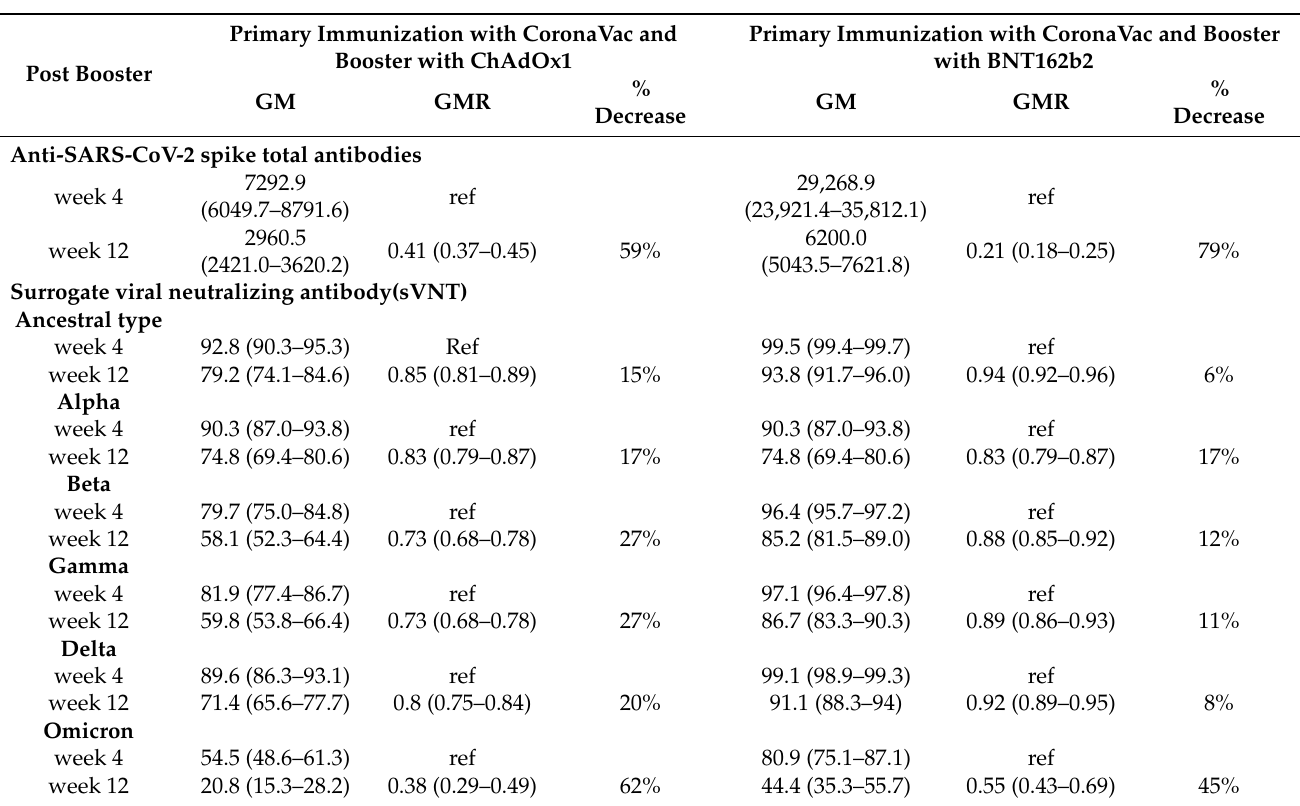
Table 3. Comparison of the changes in anti-SARS-CoV-2 spike total antibodies and surrogate viral neutralizing antibody (sVNT) by multiplex sVNT between week 4 and week 12 after the booster dose.